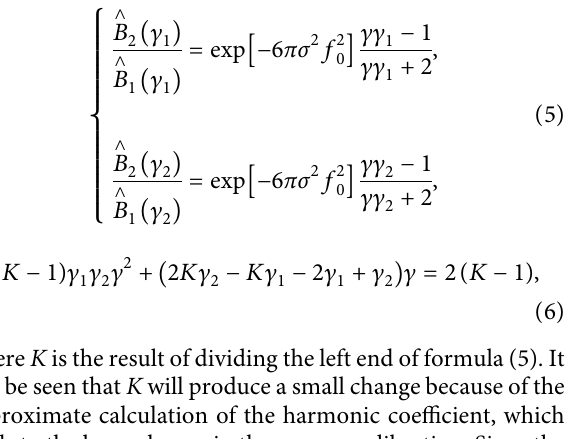
Step 1: precode the fringe pattern sequences. Two groups of digital fringe pattern sequences with different Gamma coefficients (i.e., c precoded, and each group has twelve